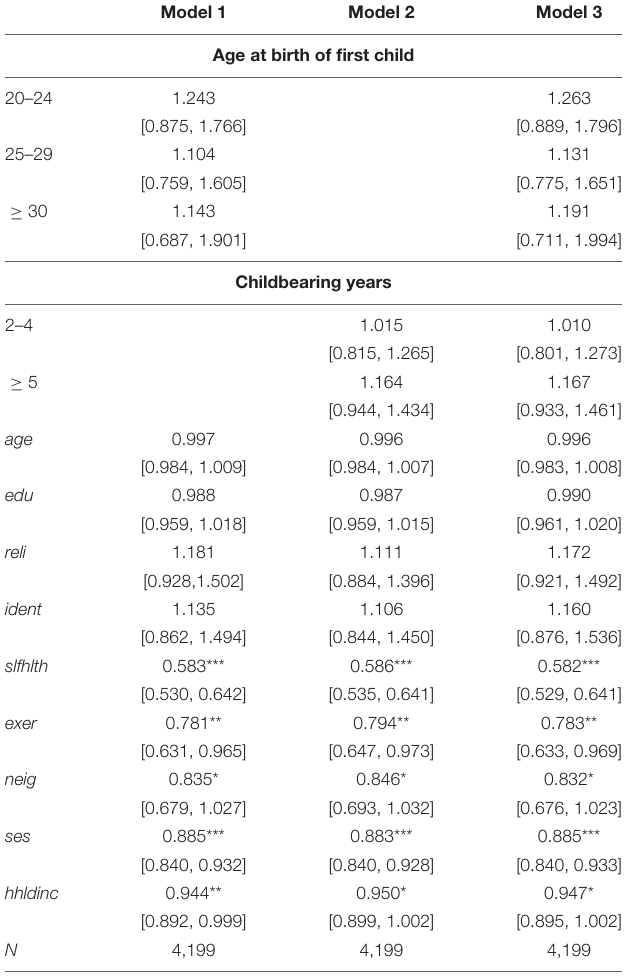
TABLE 5 | Estimates of heterogeneity analysis: childbearing